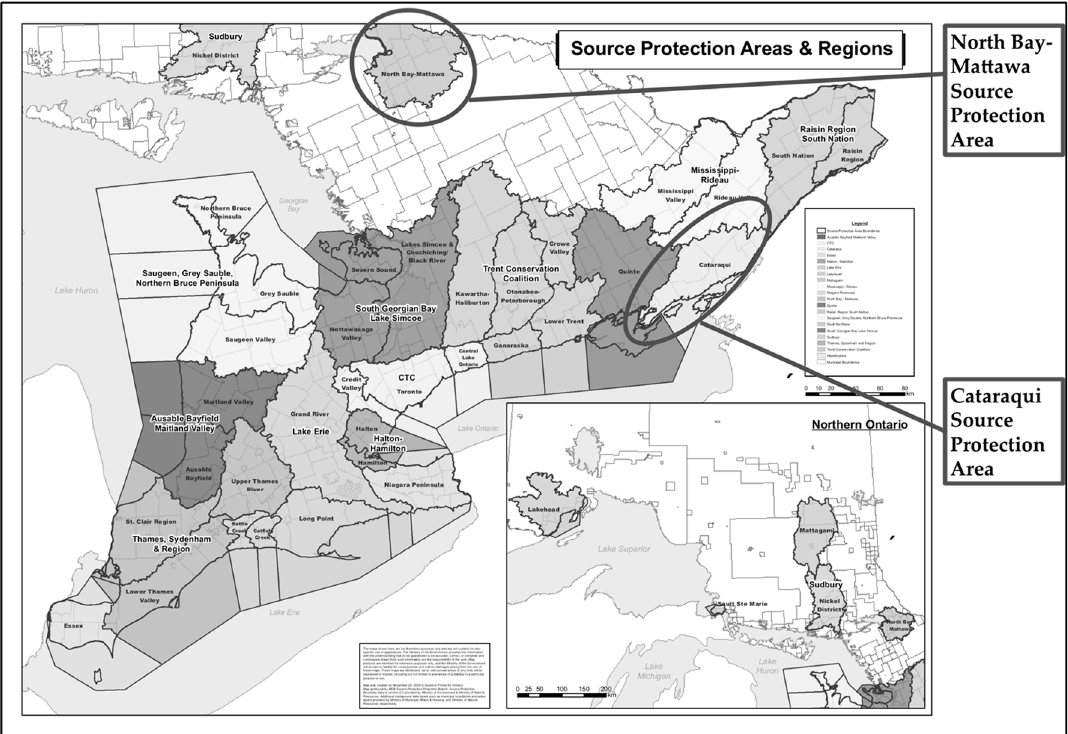
Figure 1. Case Study Locations [32].